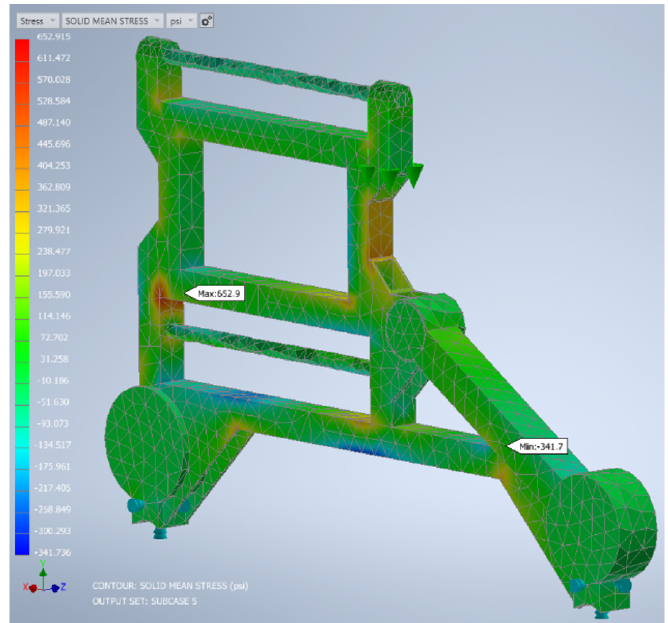
Figure 16. FEM Analysis of the mechanical structure part Drive System (left side).